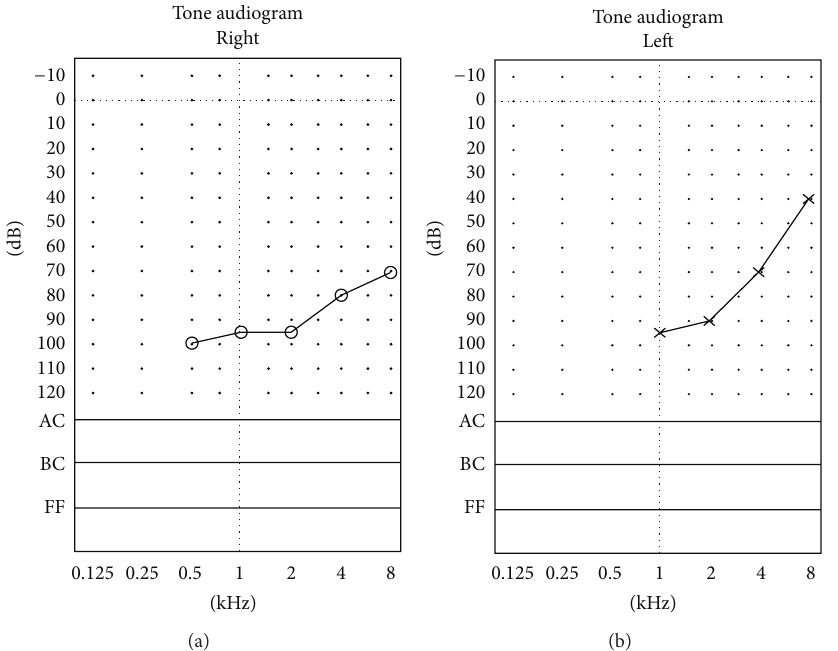
Figure 3: An audiogram revealed bilateral sensorineural deafness (performed during the second episode).